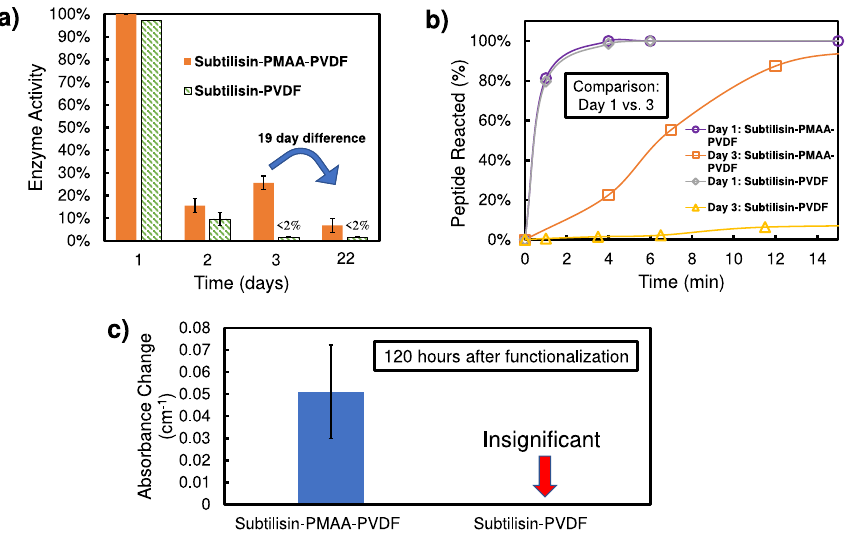
Fig. 6 Characterization of enzyme activity immobilized on membrane. a Percent of active enzymes immobilized (via batch method) on PMAA-PVDF (orange bar) and unfunctionalized PVDF400 (green striped bar) over time of dry storage with no hydration at 22 – 24 °C. Day 1 is the day enzyme immobilization occurred. The highest enzyme activity upon immobilization (Subtilisin-PMAA-PVDF) was considered 100% (0.19 mM product formed/min per mg of enzyme) and all subsequent values were normalized based on this activity. b Substrate interaction with Subtilisin-PMAA-PVDF (purple circle and line for Day 1, orange square and line for Day 3) and Subtilisin-PVDF membrane system (gray triangle and line for Day 1, yellow triangle for Day 3) 48 h after enzyme functionalization. Peptide concentration was 0.08 – 0.10 mM. c Minimal hydration (37 μ L of solution/cm 2 of membrane = 0.02% water) test of Subtilisin-PMAA-PVDF and Subtilisin-PVDF membranes 120 h after enzyme functionalization. Reaction was allowed to proceed for 60 s. Activity measured using peptide (N-succinyl-Ala-Ala-Pro-Phe-p-nitroanilide) that, upon proteolysis, releases 4-nitroanaline, which absorbs light at wavelength of 410 nm. Initial concentration of peptide was 0.08 – 0.10 mM and reactions were conducted at 23 °C. Reactions occurred at pH ranging from 7 – 8. Error bars represent the standard deviation of 3 different measurements taken on the